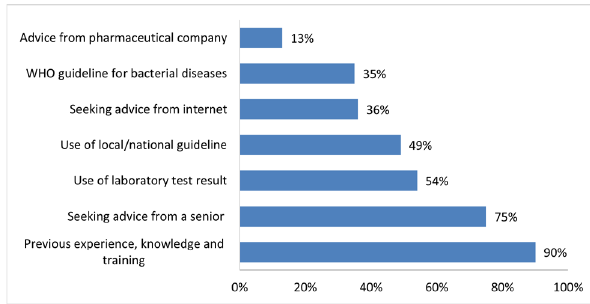
Figure 1: Different sources used by the veterinarians for selecting antimicrobials